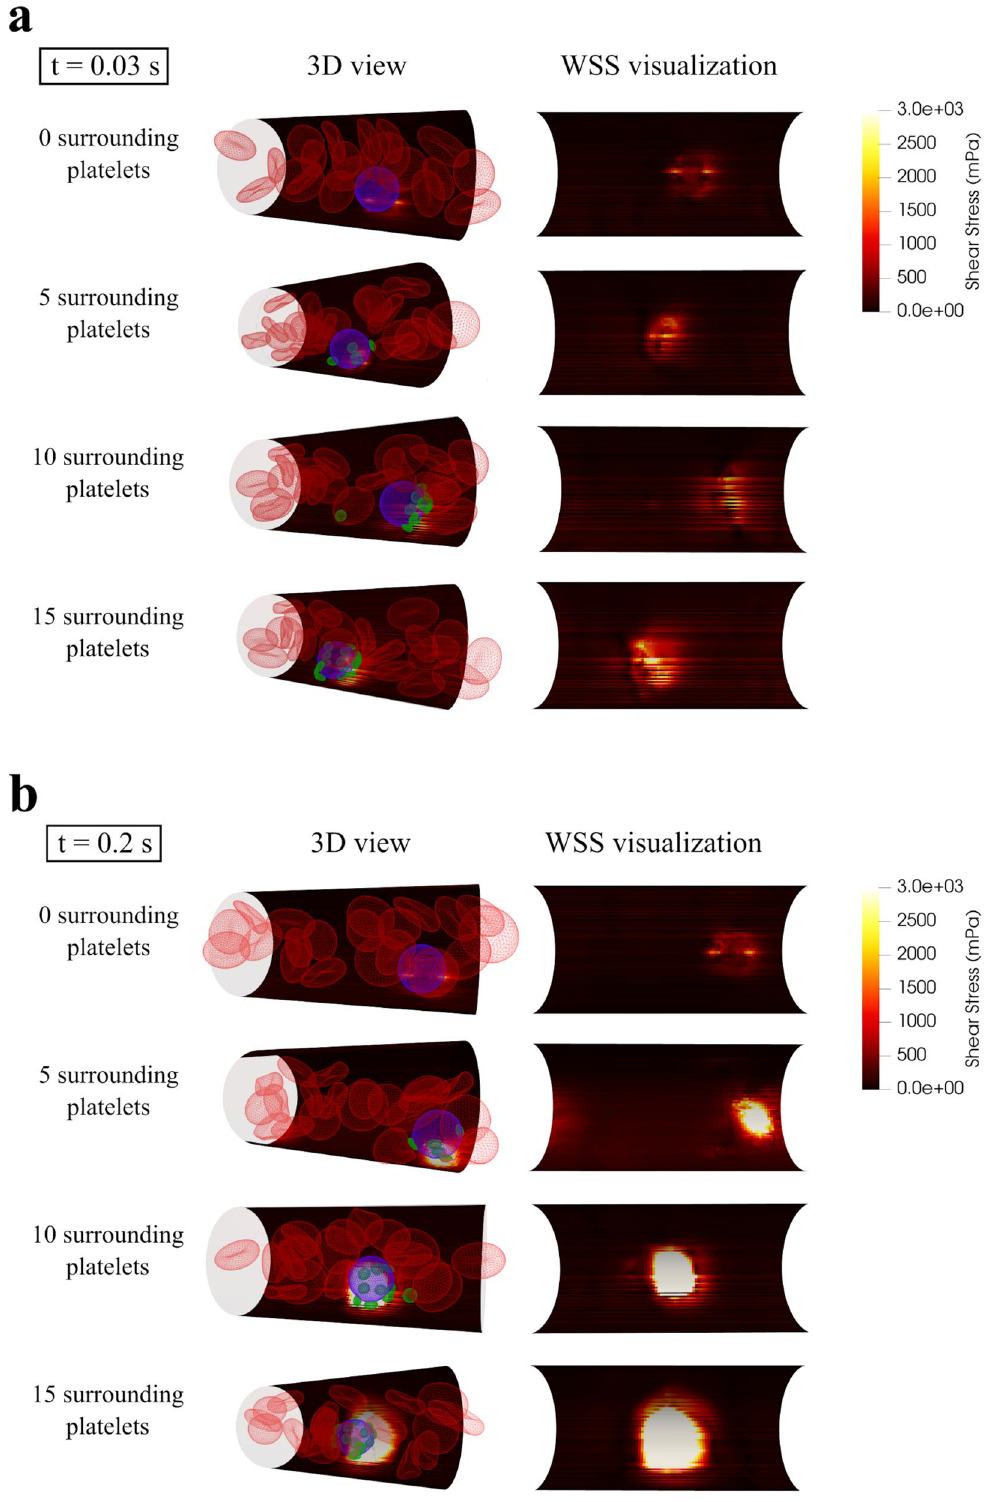
Figure 4. The wall shear stress (WSS) during rolling state and firm adhesion of the CTC. ( a ) Illustration of WSS on the microvessel wall as a result of rolling motion of CTCs and the attached platelets near the vessel wall at t = 0.03. The area of elevated shear stress expands when more platelets are attached to the CTC. High shear stress on the endothelial cells initiates the adhesion molecules that is a necessary step before firm adhesion occurs; ( b ) Illustration of the WSS on the microvessel wall for different numbers of platelets attached to the CTC at t = 0.20. When there is no platelet attached to the CTC, the CTC continues its rolling motion and the WSS is almost the same as the one at t = 0.03 ( a ). When there are platelets attached to the CTC, the firm adhesion occurs and the WSS substantially increases in comparison with rolling motion ( a ) and reaches to its maximum magnitude. Additionally, the area of the elevated WSS expands increasingly by increasing the number of attached